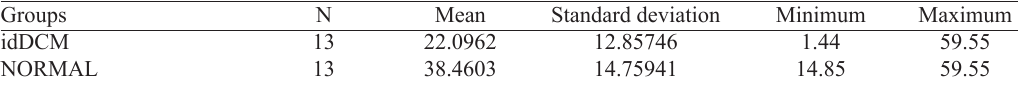
Table 6. Descriptive measures of variables collagen fibers of LVR in idDCM and NORMAL groups (percentage). Groups idDCM